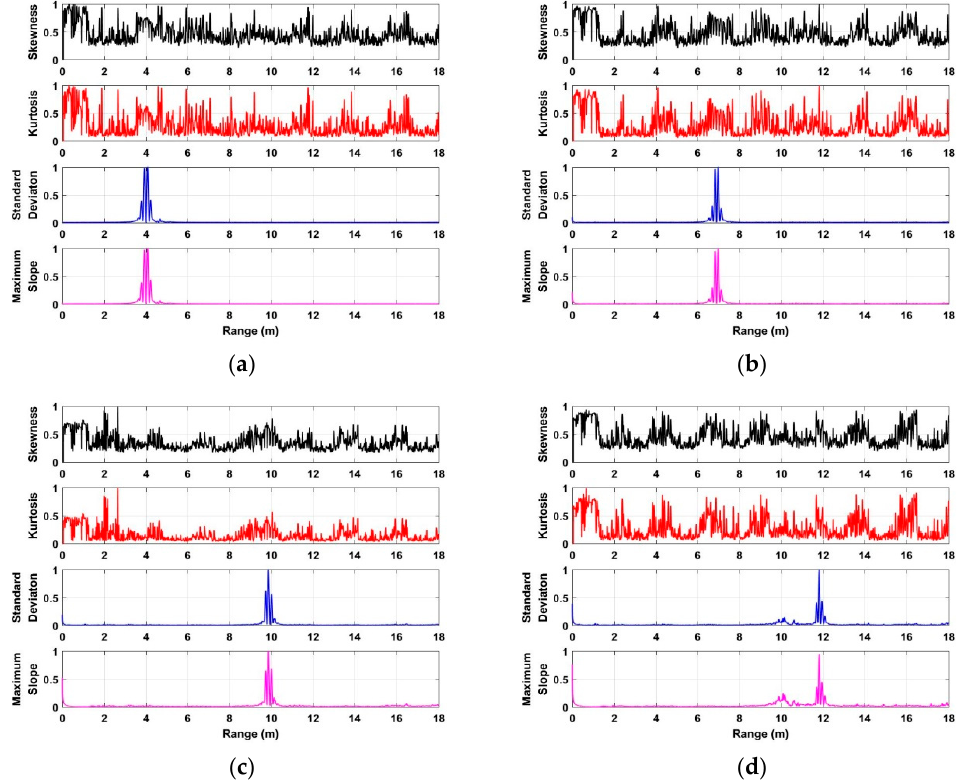
Figure 10. The distance estimates based on the acquired data from one human being at a distance of ( a ) 4 m; ( b ) 7 m; ( c ) 10 m; and ( d ) 12 m indoors.